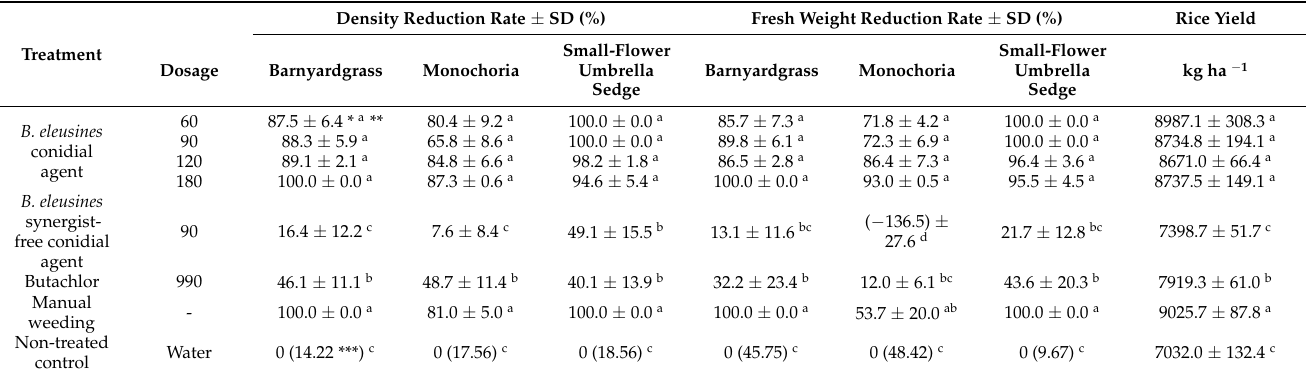
Table 5. Effects of B. eleusines agent with herbicides on weed control and rice yield at the Fuyang Experiment Station in